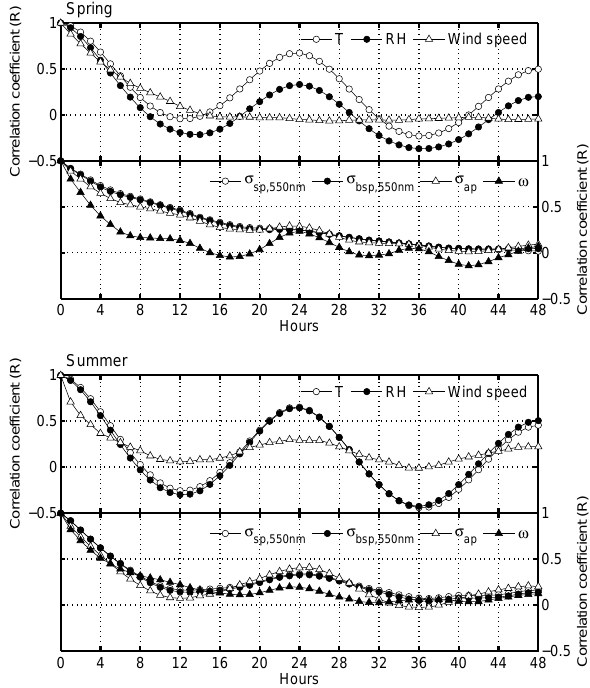
Fig. 2. Autocorrelation analysis of the meteorological parameters and the aerosol optical